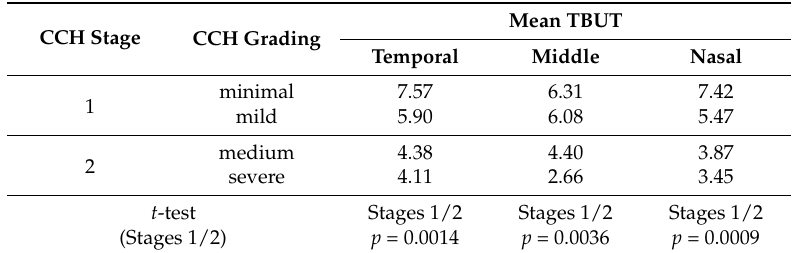
Table 5. Mean TBUT/CCH severity per location.